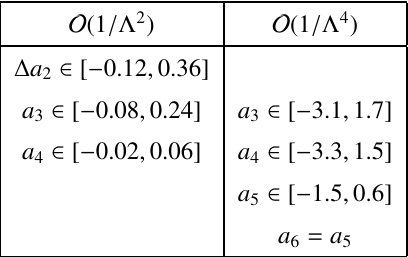
Table 2. Bounds on the a i HEFT coe ffi cients that need to be satisfied for SMEFT to exist. The first column being consistent at O ( Λ − 2 ) with 95% confidence-level [16]) experimental bounds / 2 ∈ [0 . 97 , 1 . 09]. The second column corresponds to the next order a 1